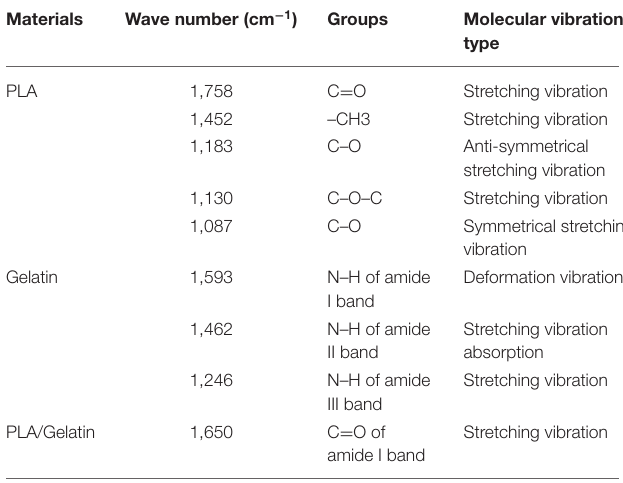
TABLE 1 | The attribution of